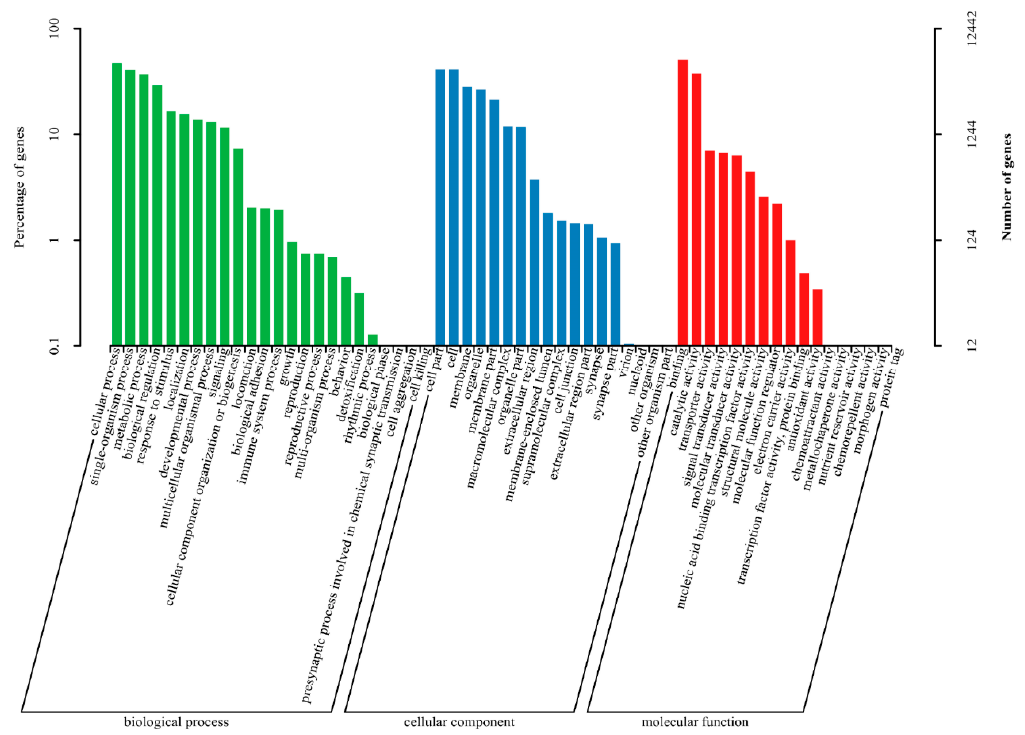
Figure 5. All genes GO cluster distribution. Genes were classified into three main categories: Biological process, cellular component, and molecular function.